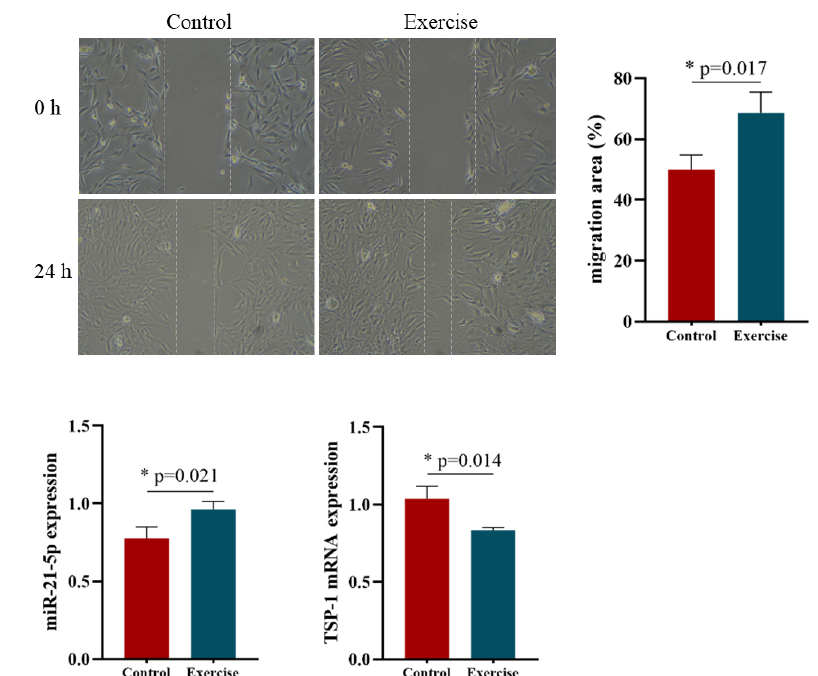
Figure 2. Effect of 8-week aerobic exercise on the senescence, proliferation, and migration of EPCs in aged rats. ( a ) Senescence rate of EPCs determined using SA- β -gal staining. ( b ) Cell proliferation analyzed using MTT assays. ( c ) Cell migration rates at 0 and 24 h after scratching. ( d ) Comparison of miR-21-5p and TSP-1 expression between control and exercise groups. * p < 0.05, ** p < 0.01. Bar, 100 μ m.